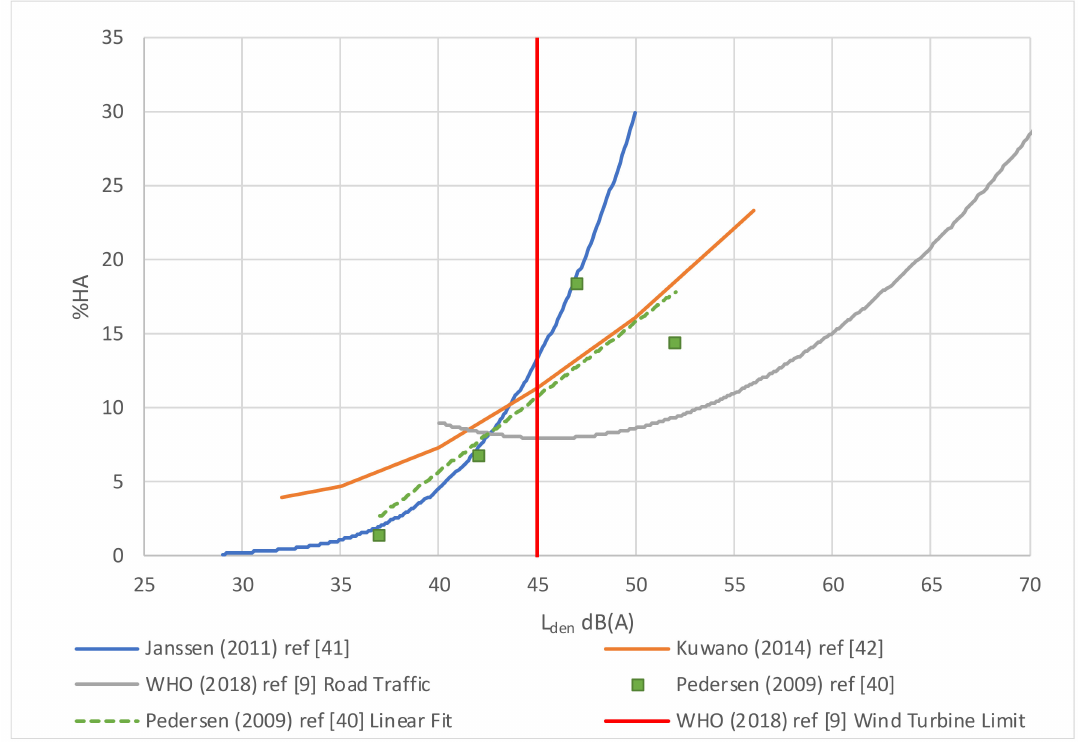
Figure 1. Proportion of respondents highly annoyed from wind turbines, Pedersen (2009), Janssen (2011), Kuwano (2014), re L den and compared with road tra ffi c (WHO